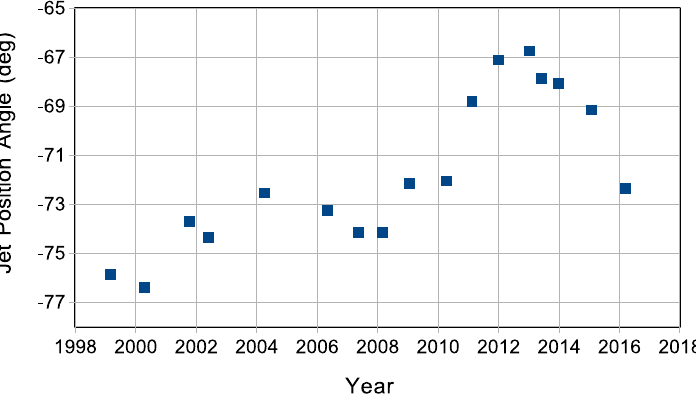
Figure 7. The time history of the position angle (counterclockwise from north) of a line between the core and the transverse midpoint of the jet at a core distance of 3 mas. The angle is measured directly from the images, which show the jet in projection. The points are suggestive of a 9-year cycle superimposed on a